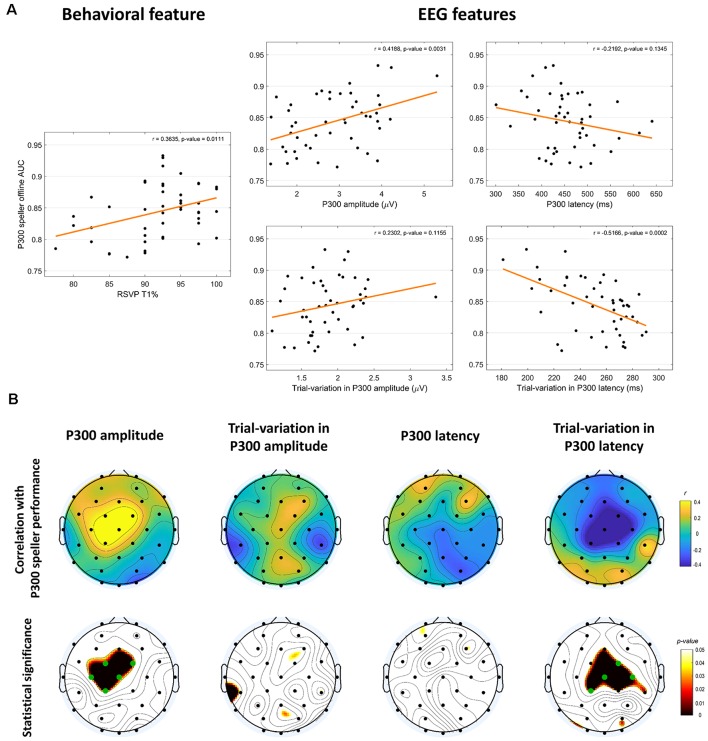
Association with P300 speller performance. (A) Relationship between the various RSVP features and P300 speller performance using Pearson’s correlation coefficients and linear regression analysis. RSVP T1% is a behavioral feature and the others are RSVP EEG features. All except P300 latency and trial variation in P300 amplitude were correlated significantly with P300 speller performance. (B) The spatial patterns of the relationship between RSVP EEG features and P300 speller performance. Pearson’s correlation coefficients and their statistical significance (uncorrected p-values) are presented in the top and bottom row, respectively. The green dots in the scalp topography in the bottom row denote significant channels after FDR-correction.